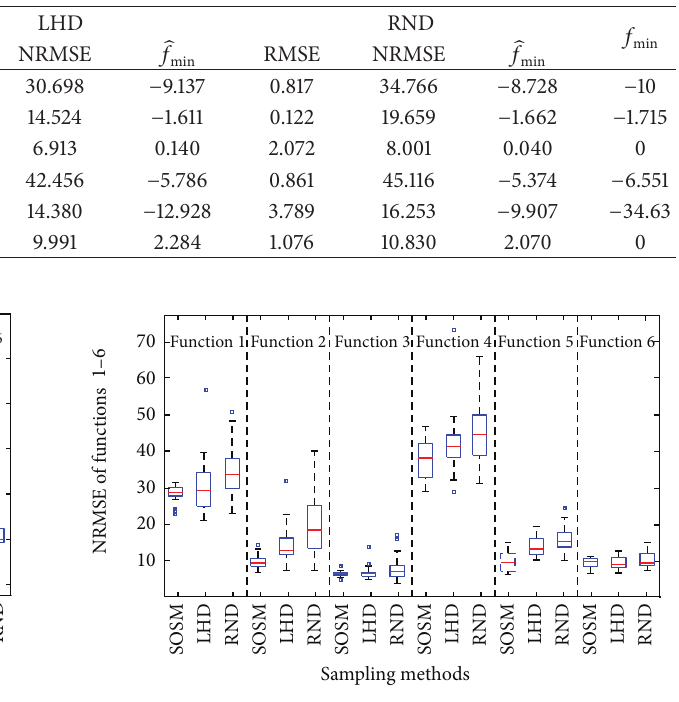
Figure 7: Assessment of metamodels: RMSE between SOSM and one-stage sampling methods.